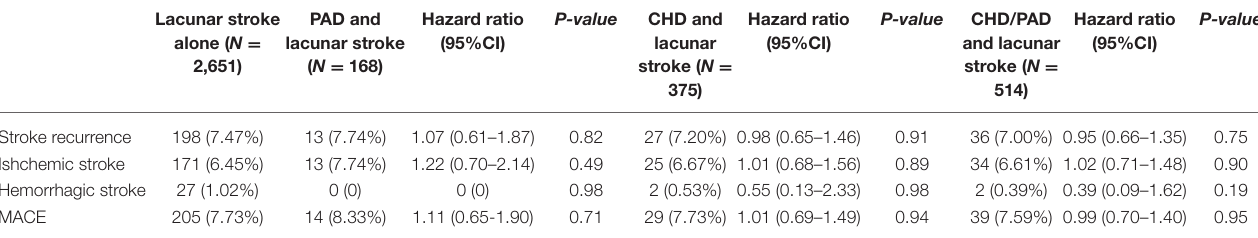
TABLE 2 | Outcomes in patients who were classified as having lacunar stroke at 1 year stratified by polyvascular disease.